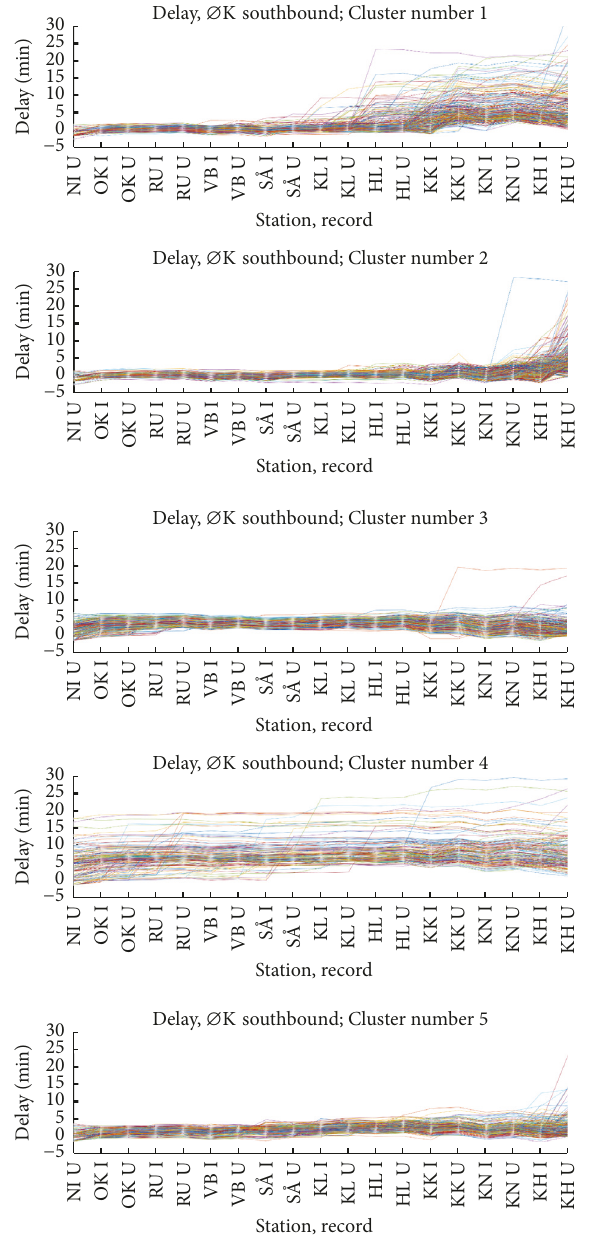
Figure 2: Resulting clusters in southbound ØK trains,